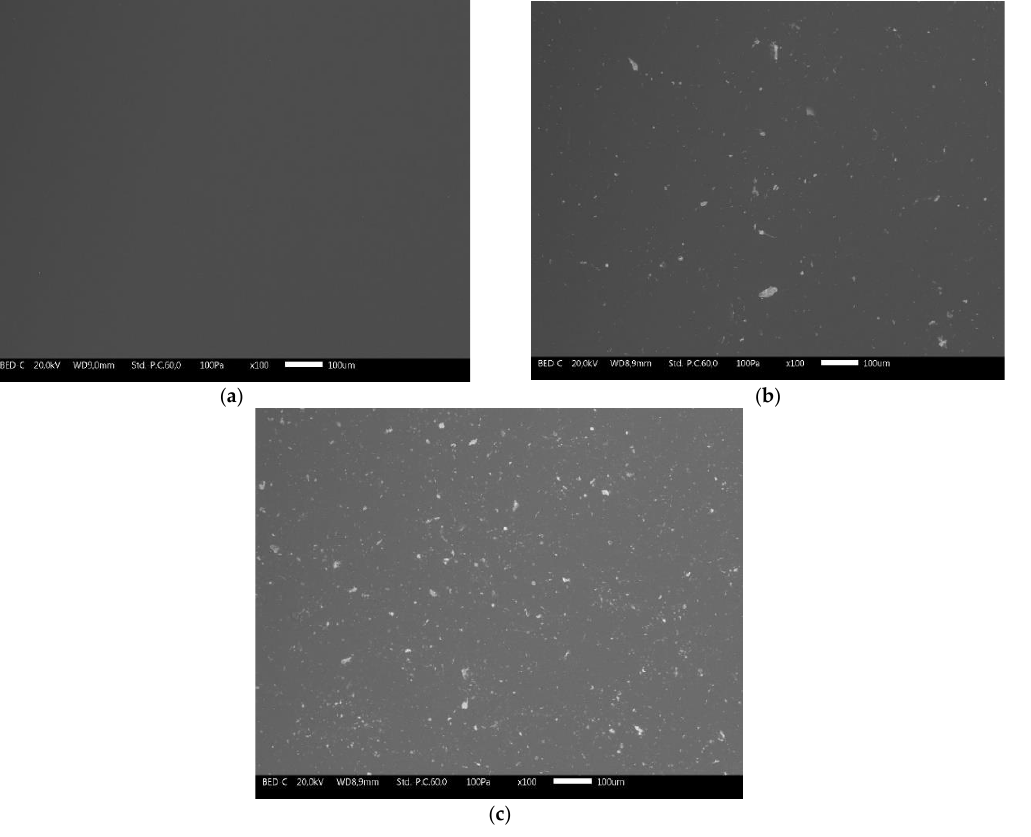
Figure 4. SEM micrograph of the surface of sample A ( a ), sample A1 ( b ) and sample A2 ( c ), respec- tively.